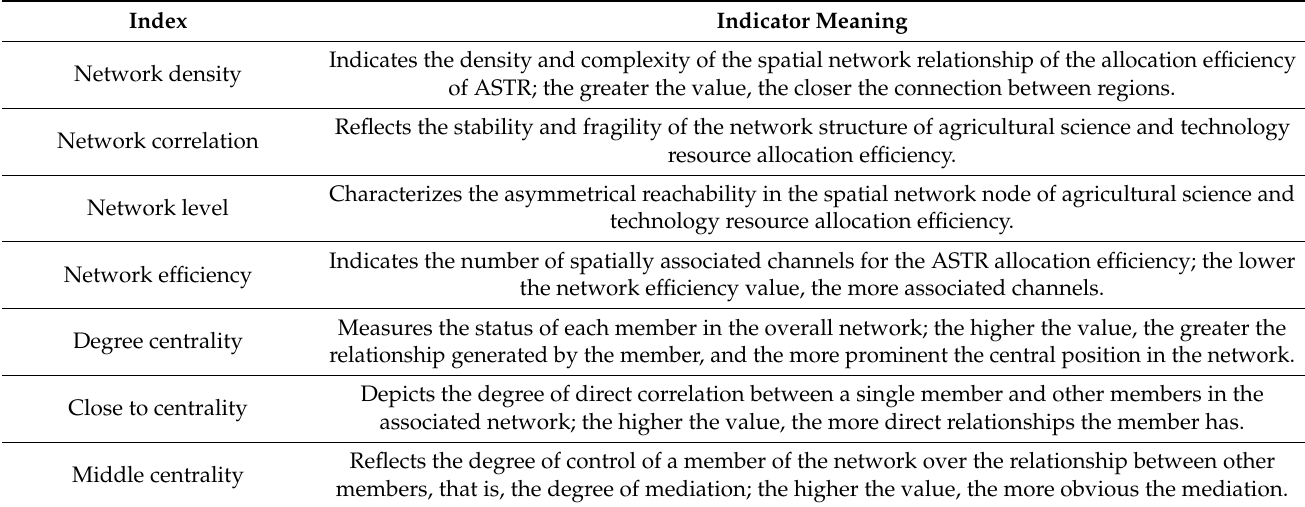
Table 2. Indexes used to measure the overall structural characteristics of the spatially correlation network of ASTR allocation